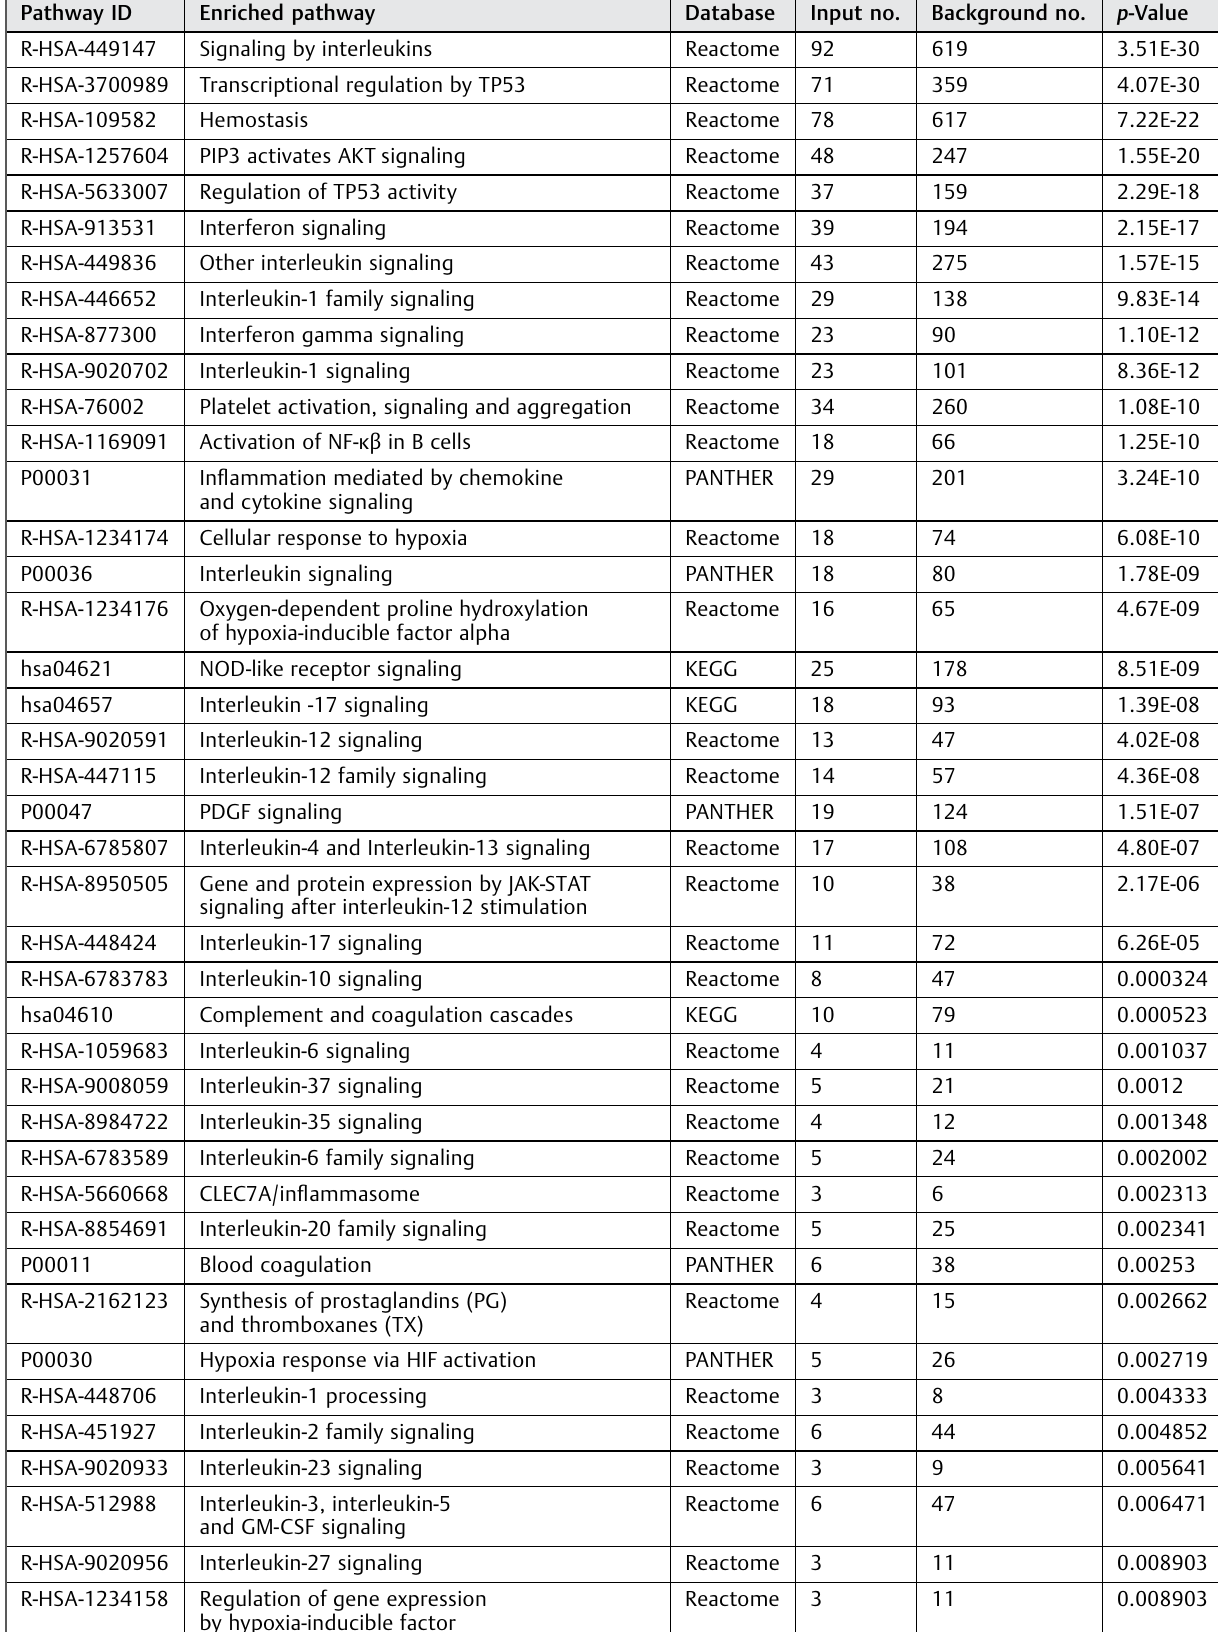
Table 1 Enrichment analysis of the shared DEGs in the meta-analysis according to